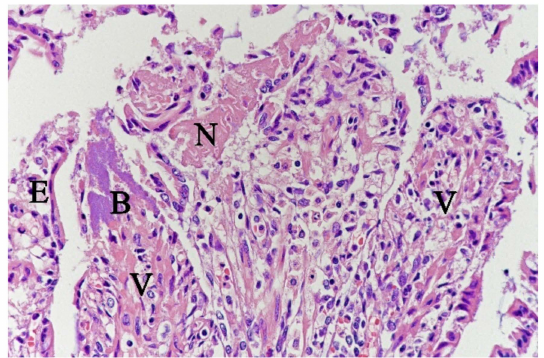
Figure 4. Histological section from small intestine dog with acute haemorrhagic diarrhoea, HE-stain. There was a loss of surface epithelium, necrotic epithelial cells (N), and elongated/stretched epithelial cells (E) trying to cover lamina propria . Note the abundance of bacteria (B) in a necrotic area on one of the villi